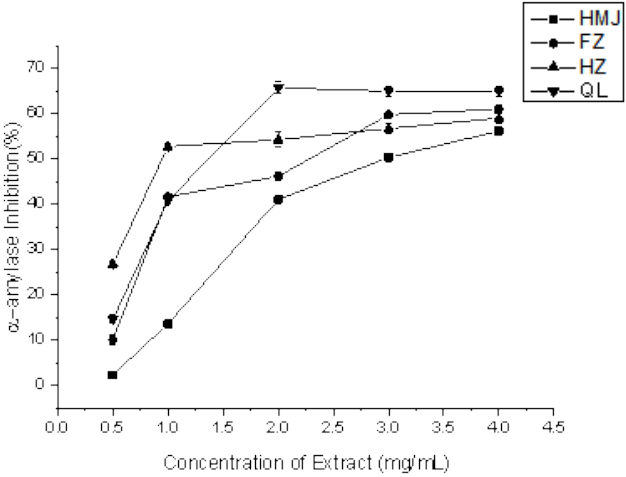
Fig. 4: Inhibitory activity against α-amylase of different concentrations of four kinds of complete black tea proteins. Mean ± SD (n=4).